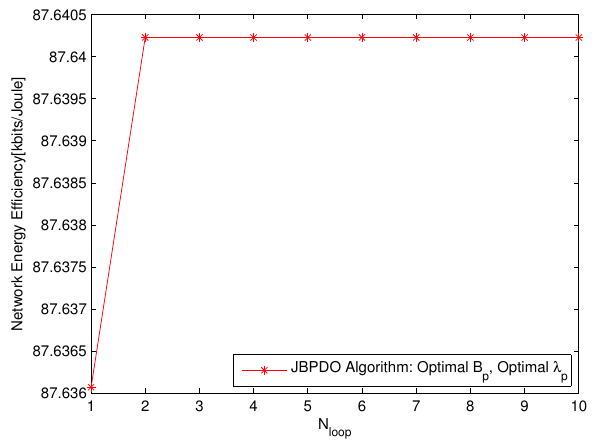
Figure 8. The network EE versus iteration times N l oop of JBPDO